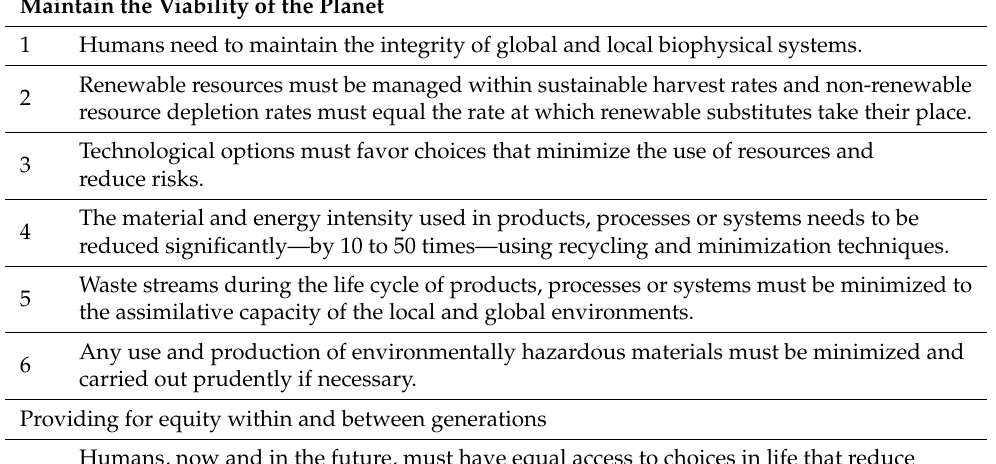
Table 4. Three key principles with 15 principles of sustainability and engineering in New